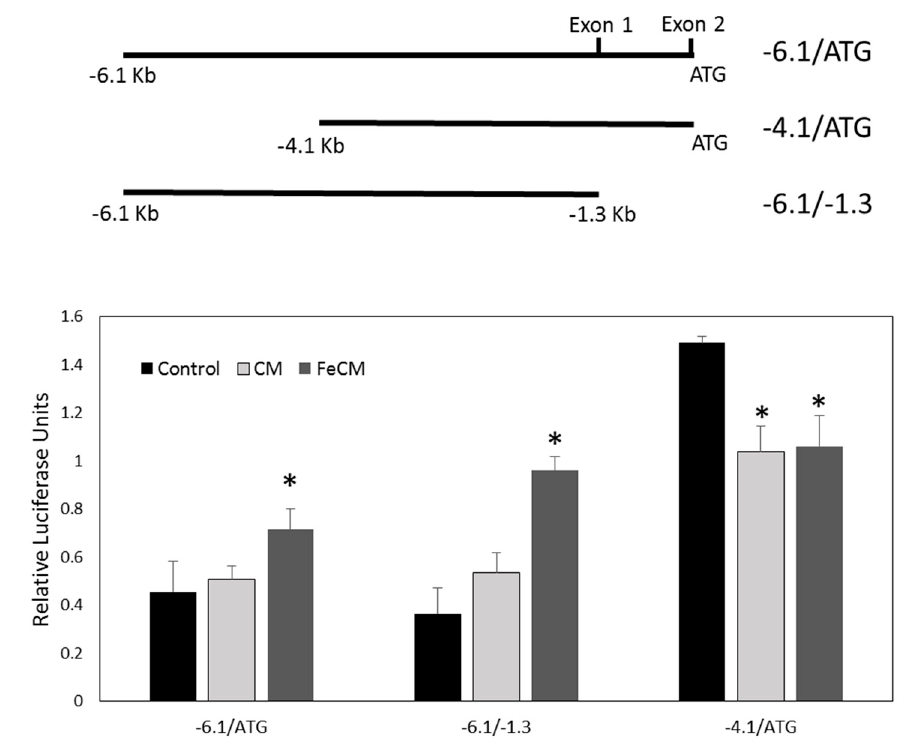
Figure 7. SNCA transcriptional activity. We wished to determine if the change in α -syn protein levels in cells treated with iron-fed microglial conditioned medium was due to a change in activity of the promoter of cytosolic protein alpha-synuclein ( α -syn), SNCA. We used three reporter constructs containing fragments of the SNCA promoter that drive luciferase expression when transcriptionally active. The fragments are illustrated by the schematic which shows the overlap with the main features of the SNCA promoter. − 6.1/ATG covers the majority of the promoter as well as the 5 (cid:48) non-coding domain prior to the start codon. − 6.1/ − 1.3 covers the same part of the promoter as − 6.1/ATG but excludes the non-coding exons. The fragment − 4.1/ATG excludes 2 kb of the sequence at the 5 (cid:48) end of the promoter. SH-SY5Y cells were transiently transfected with the three constructs and the cells were treated for 24 h with either serum free medium (control), conditioned medium from C8B4 microglia (CM) or conditioned medium from iron-fed C8B4 microglia (FeCM). Readout of luciferase activity showed that conditioned medium from C8B4 microglia had no significant effect on the − 6.1/ATG or − 6.1/ − 1.3 promoter fragment, while iron-fed conditioned medium caused a significant increase ( p < 0.05) in activity. In contrast the conditioned medium from both kinds of microglia decreased the activity seen with the − 4.1/ATG fragment. The difference in activity suggests that the change in expression of α -syn may come from binding of a transcription factor between − 6.1 and − 4.1 on the SNCA promoter in response to a factor in iron-fed microglia conditioned medium. Shown are the mean and S.E.M. of four separate